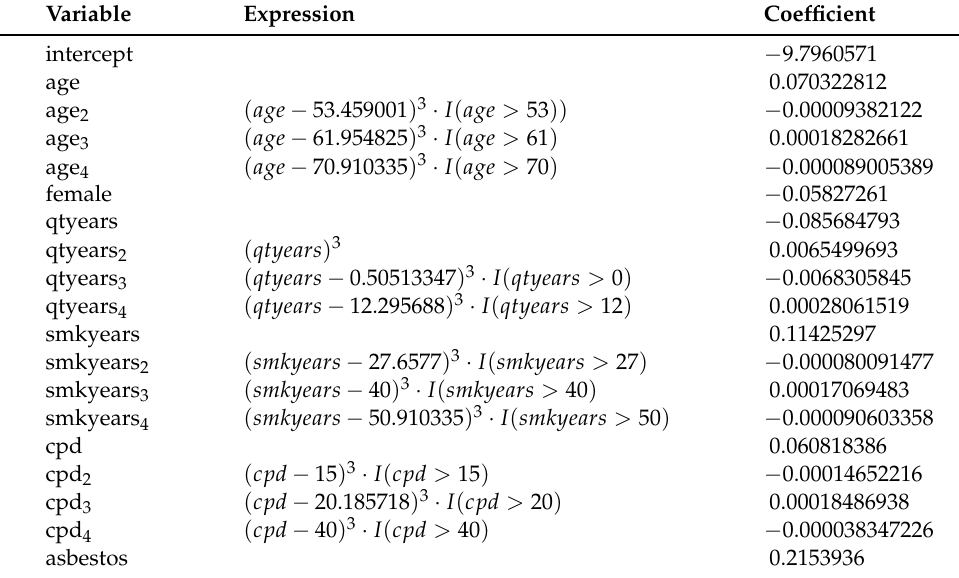
Table 2. Beta coefficients estimated in the BACH